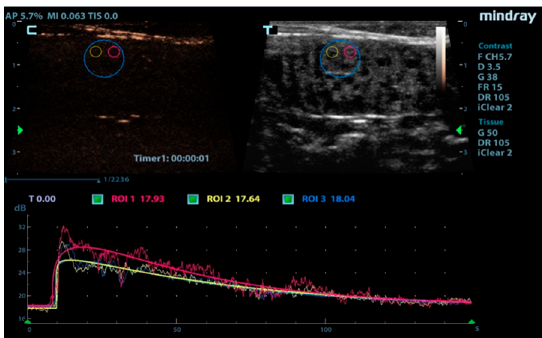
Figure 1. The region of interests (ROIs) were manually drawn into the near field of the endometrium: the large ROI encompassed the two smaller ones. At the bottom of the image raw curves (broken line) and fitted curves (continuous line) are consistent with the colors of the